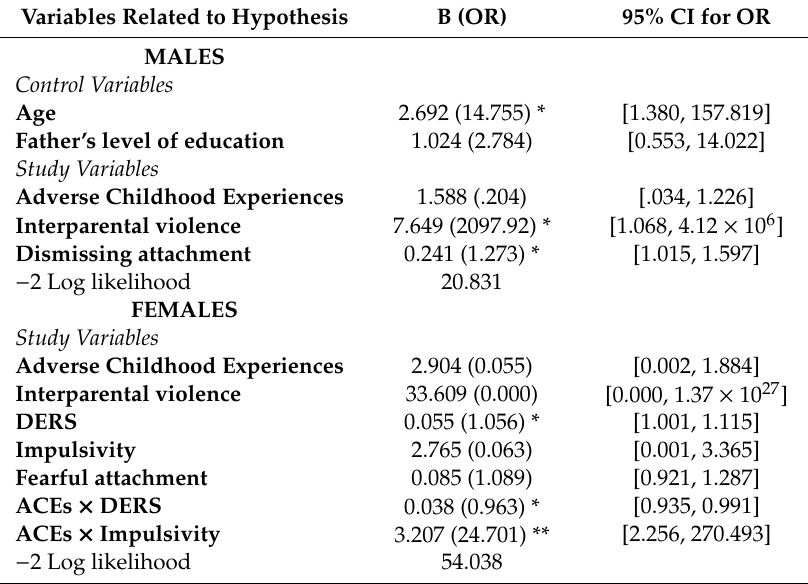
Table 7. Logistic regression: Relationship between study variables and minor / moderate physical TDV perpetration in males and